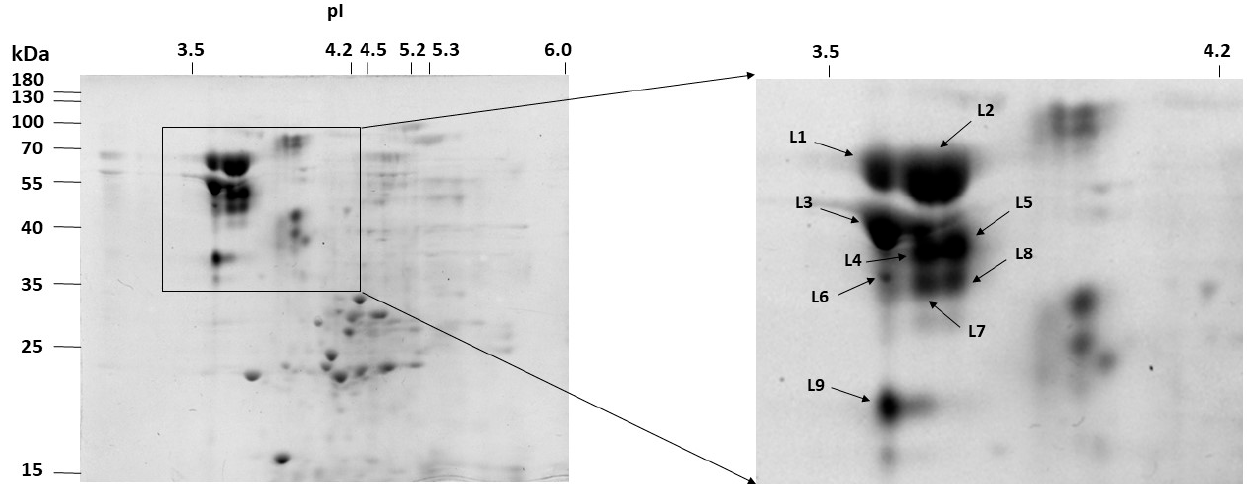
Figure 4. The 2D-gel separation of extracellular protein from the 8-day-old C. unicolor culture . Spots corresponding to the identified laccase enzymes are designated from L1 to L9.